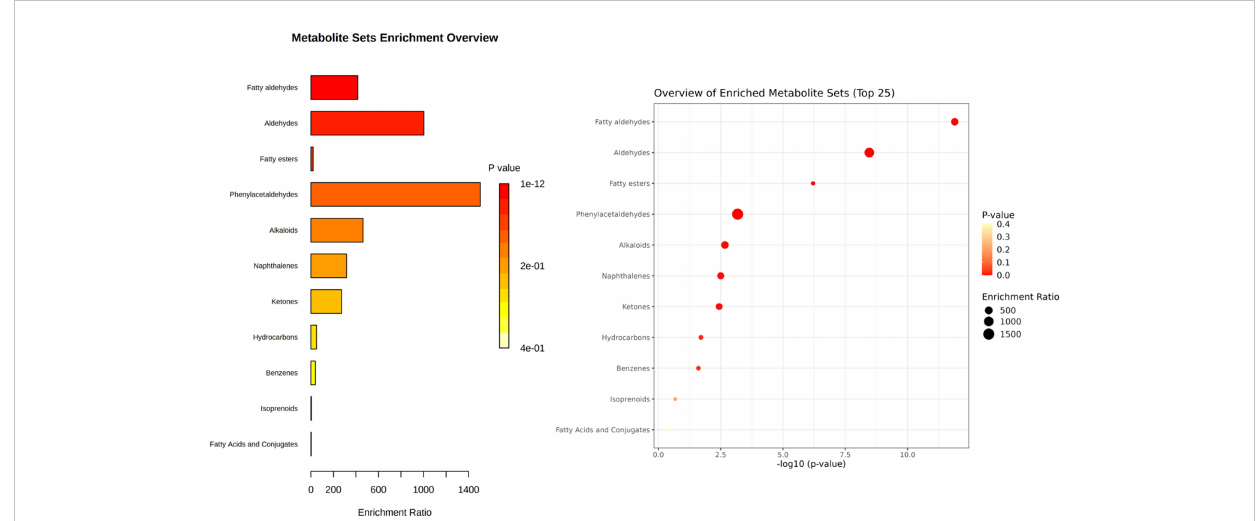
FIGURE 2 Overview of volatile compound groups identi fi ed from 23 Thai rice varieties (aromatic white rice, aromatic black rice, non-aromatic black rice, and non-aromatic red rice). Metabolite sets (volatile compounds) are classi fi ed by sets of main-class chemicals. The bar chart ’ s colors are determined by the p-value. For dot plot, each color and size are determined by p-value and the enrichment ratio, respectively.